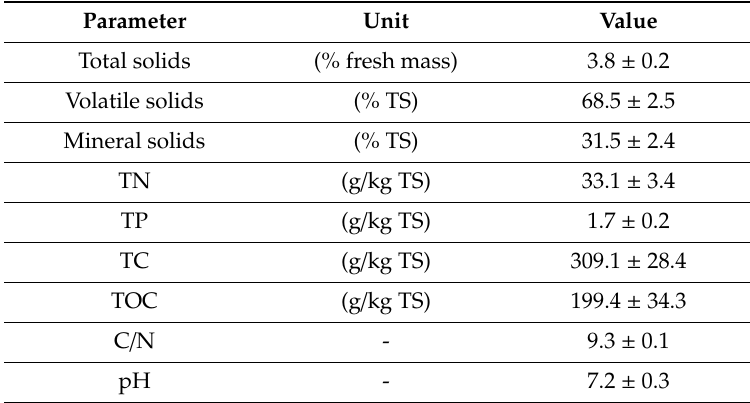
Table 4. Characteristic of anaerobic inoculum for batch anaerobic digestion (AD) assays